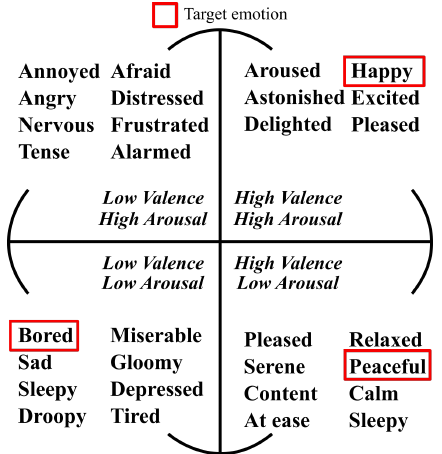
Figure 1. Russell’s circumplex